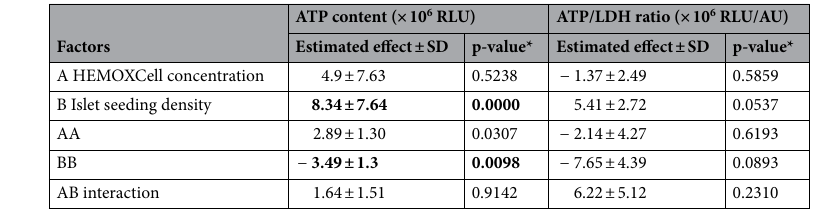
Table 5. Estimated effects of factors and interactions and their statistical significance in the optimization DoE (with silicone-CaO 2 ). *p-values are computed from the analysis of variance performed for each response (Supplementary Tables 4 and 5) and statistical significance at 5% are highlighted in bold.